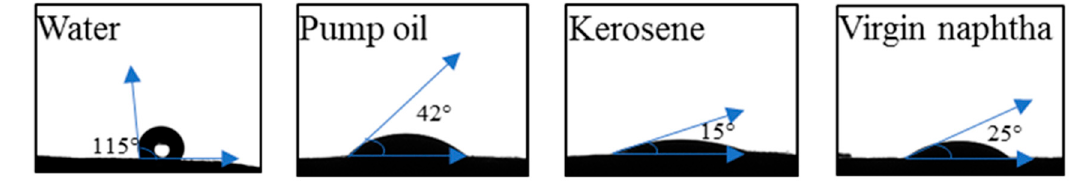
Figure 10. The contact angle of investigated liquids for F-CNT22.